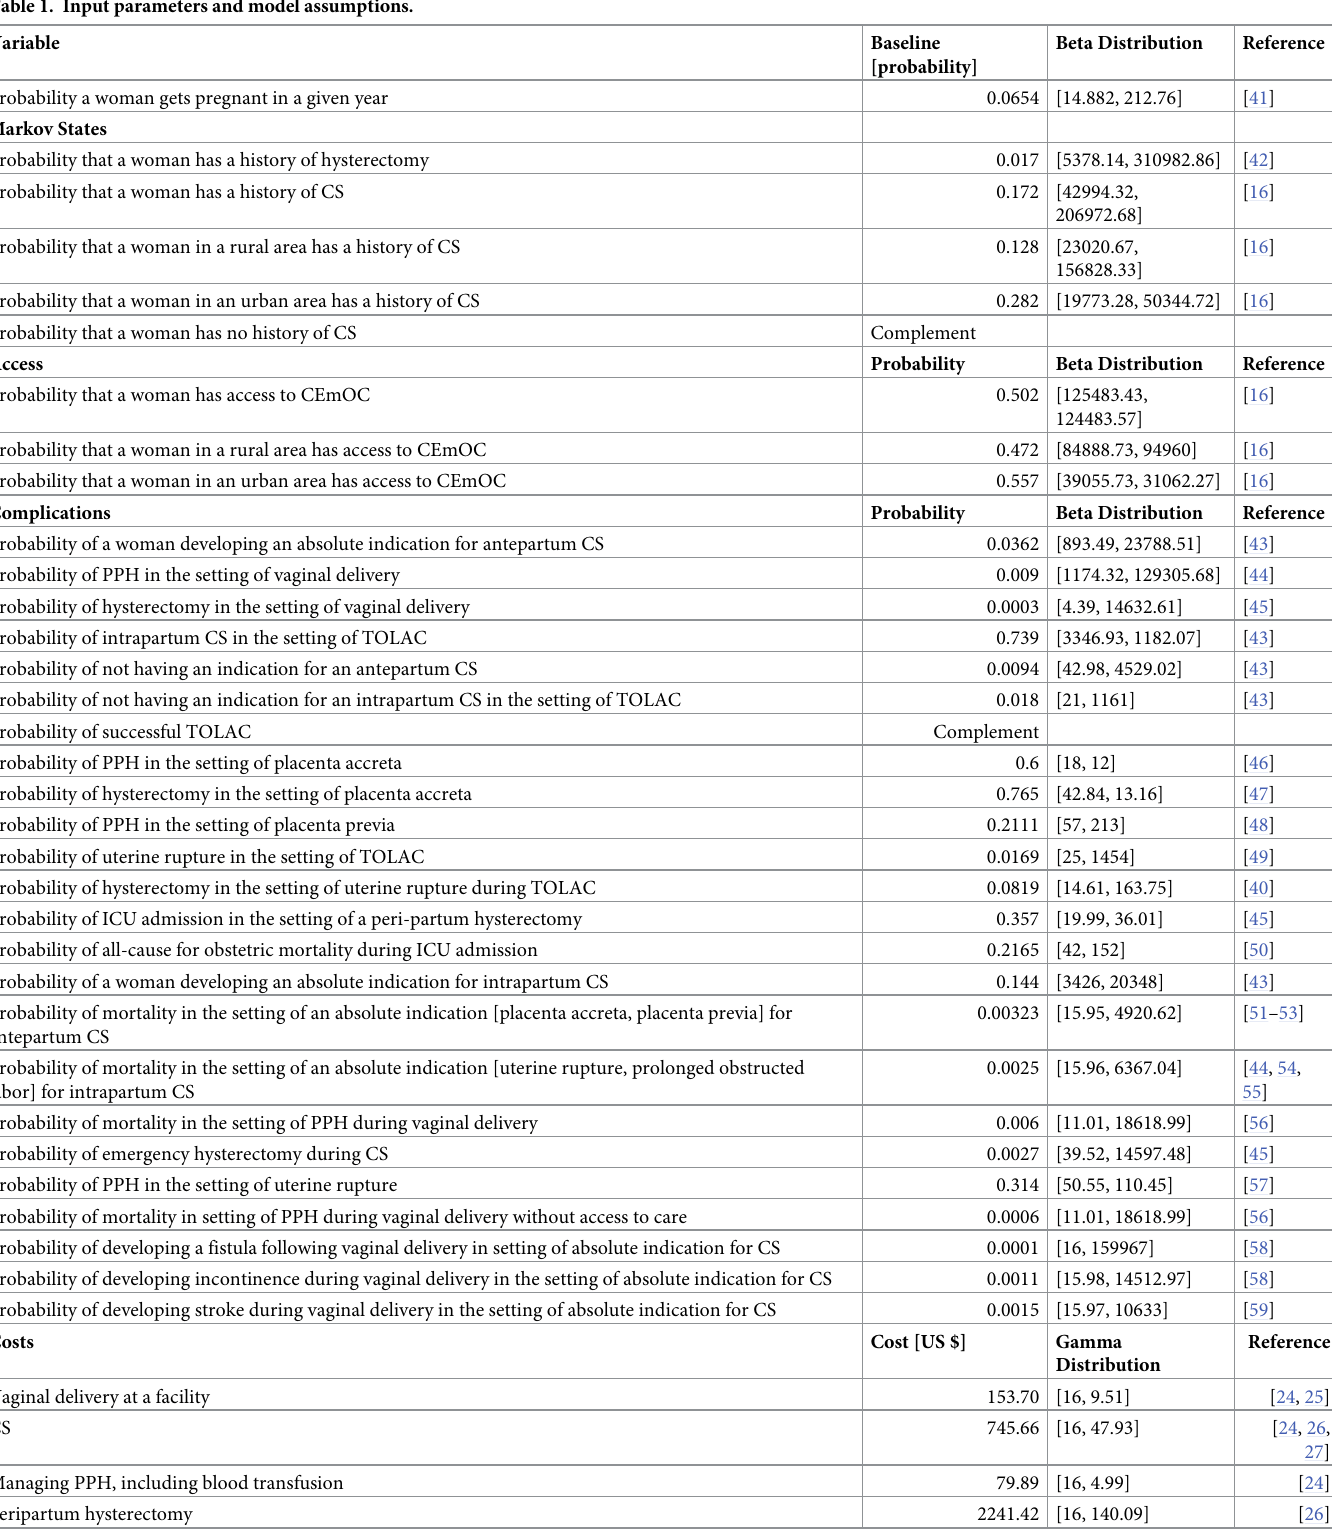
Table 1. Input parameters and model